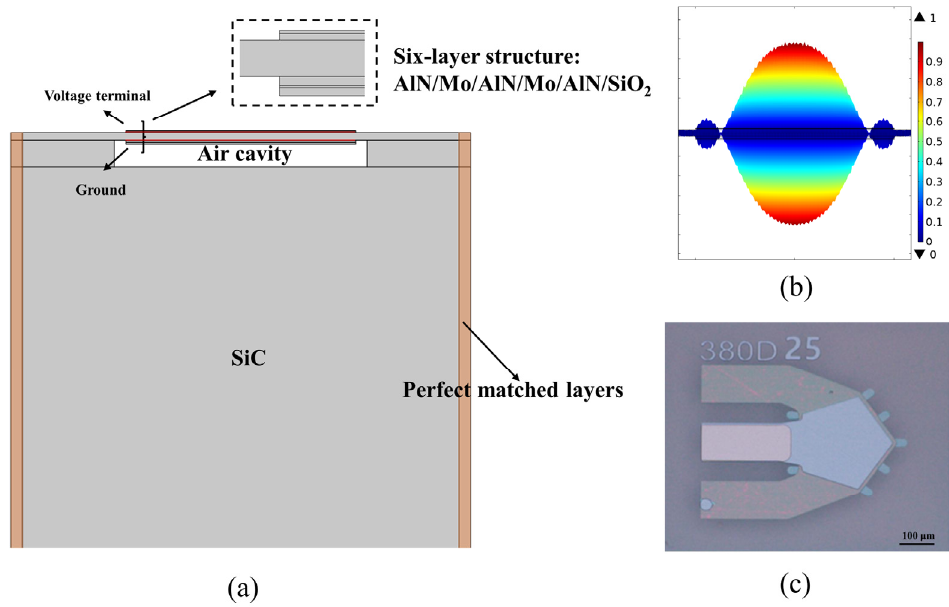
Figure 4. Single crystal AlN BAW resonators, ( a ) Model structure in FEM simulation, ( b ) FEM sim- simulation displacement at the resonant frequency and ( c ) fabricated device. ulation displacement at the resonant frequency and ( c ) fabricated device.